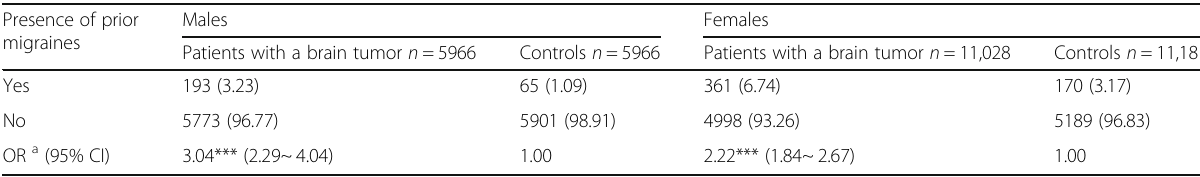
Table 4 Odds ratios (ORs) of prior migraines among patients with a brain tumor and the controls according to sex ( n = 22,650) Presence of prior migraines